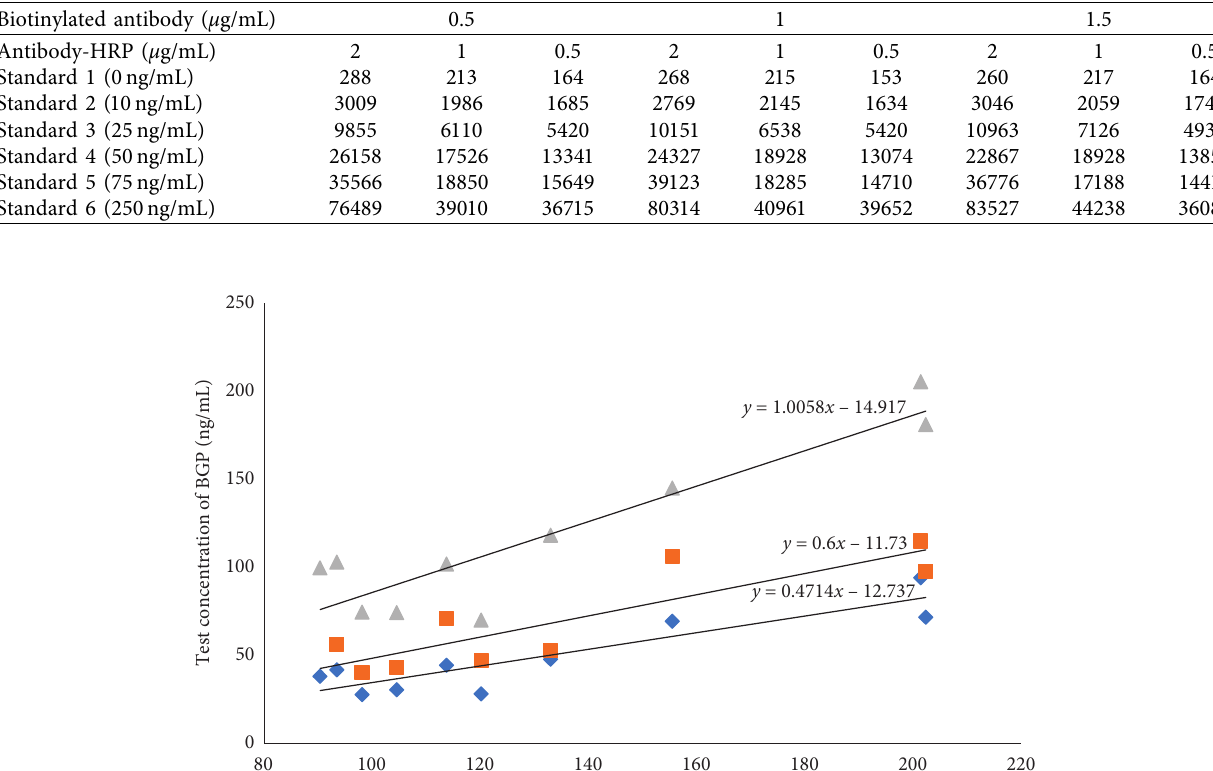
Table 2: Optimisation of antibody concentration.